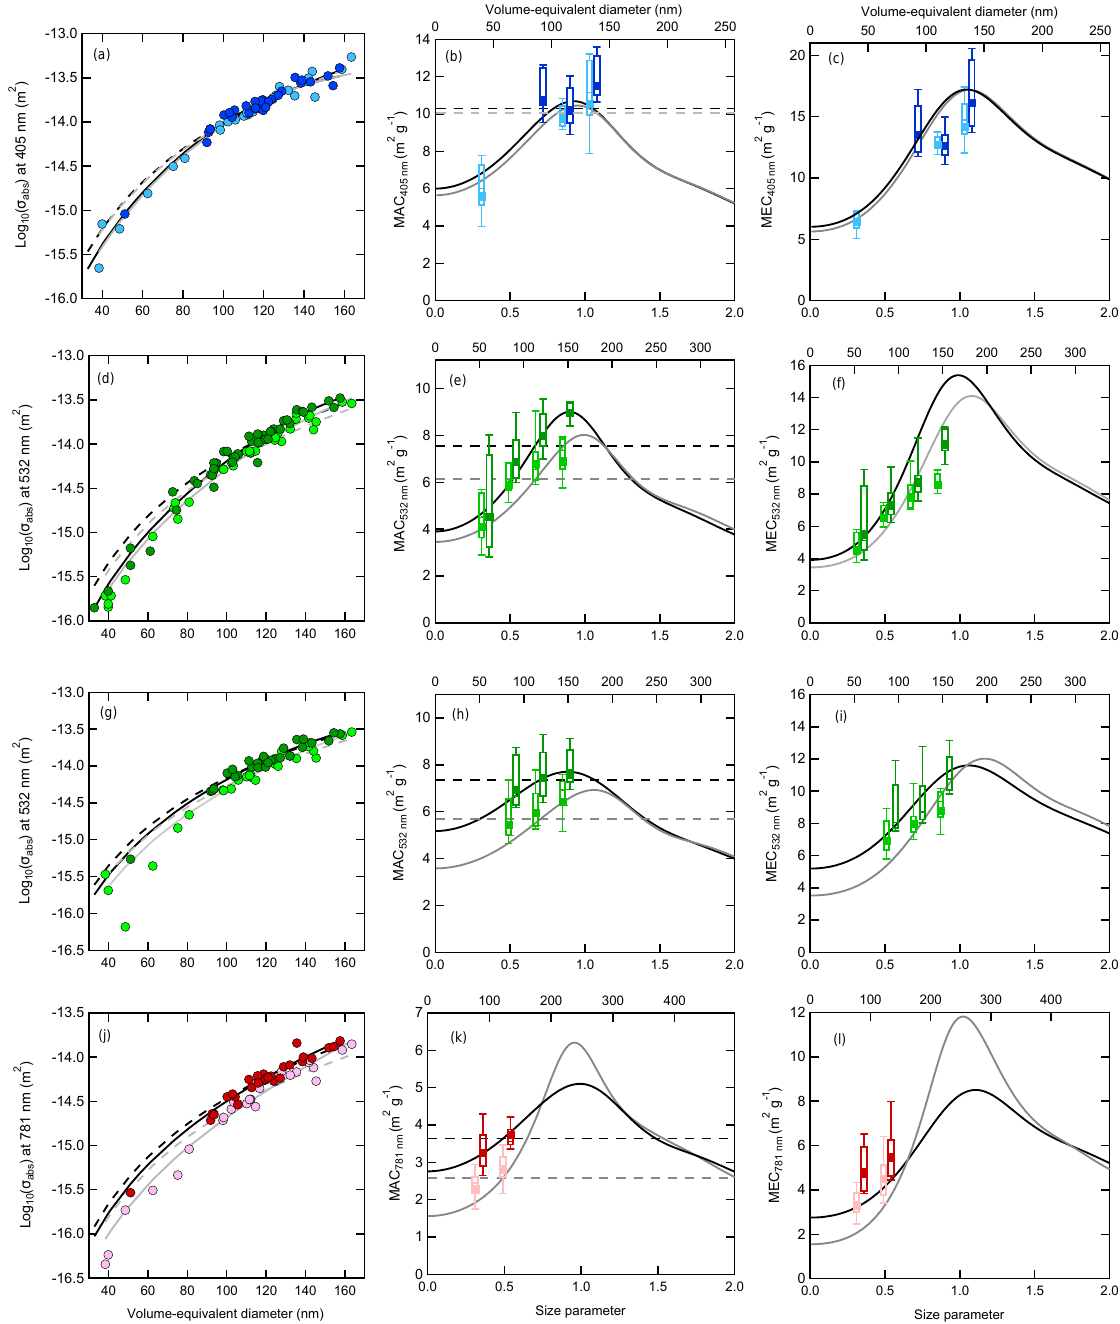
Figure 5. Measured absorption cross sections vs. volume-equivalent diameter (panels in the first column) and mass absorption and extinction coefficients (MACs and MECs; panels in the second and third column, respectively) for ethylene soot sampled 20.3cm from burner surface of the McKenna flame as a function of size parameter ( x = πd p /λ ) (bottom axes) and volume-equivalent diameter (top axes). for BC2. Panels (a–c) show PASS-3 data at λ = 405nm, (d–f) show NOAA PAS data at λ = 532nm, (g–i) show PASS-3 data at λ = 532nm, and (j–l) show PASS-3 data at λ = 781nm. The dashed black and gray lines are the RDG fits to denuded and nascent data, respectively, and the solid black and gray lines are Mie fits to denuded and nascent data,